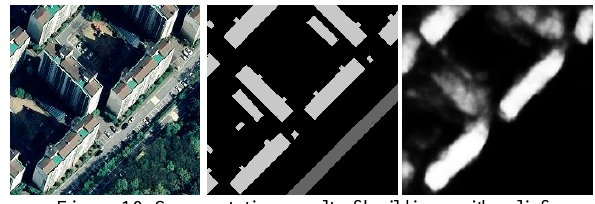
Figure 10. Segmentation result of buildings with relief